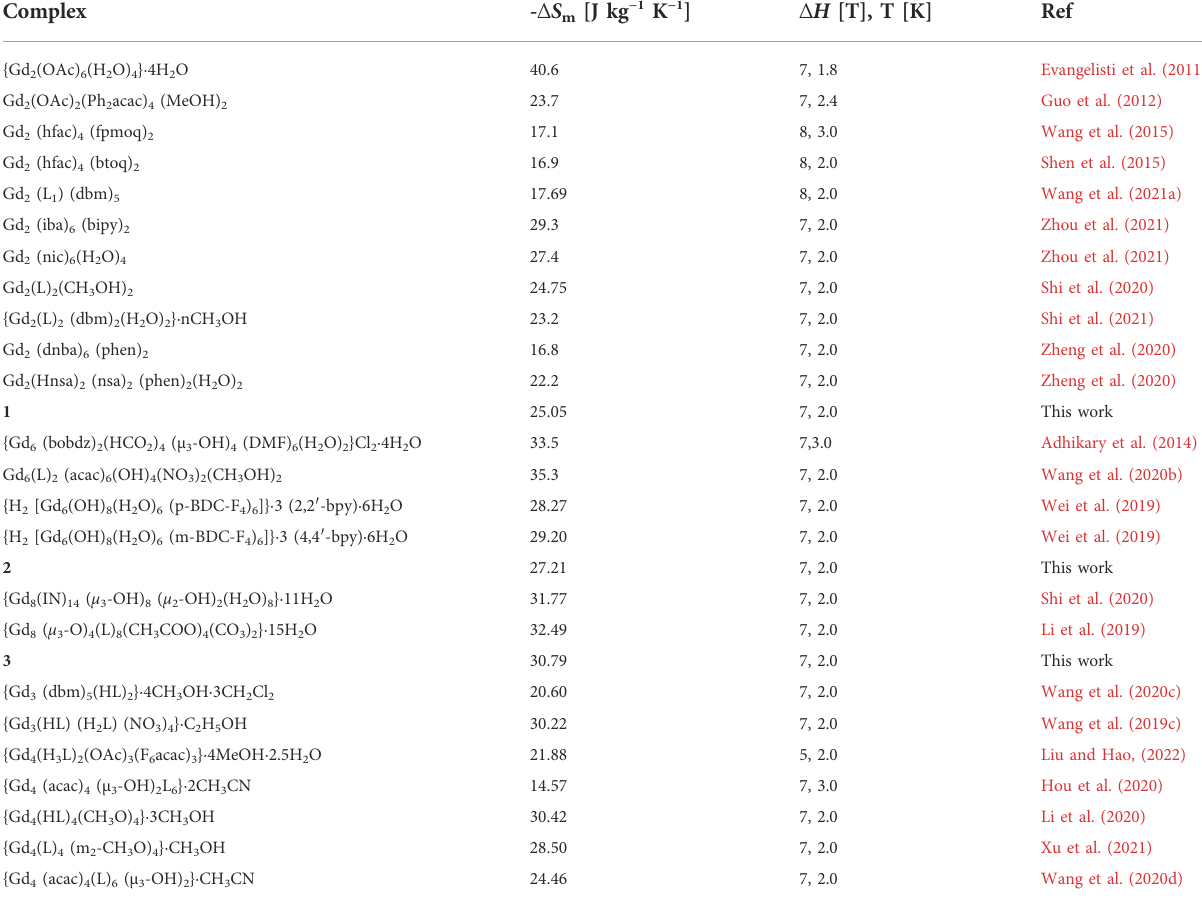
TABLE 2 Summaryof - Δ S m in different Δ H at a giventemperature for reported di-nuclearity,hexa-nuclearity, octa-nuclearity,andothermultinuclear Gd-based complexes.